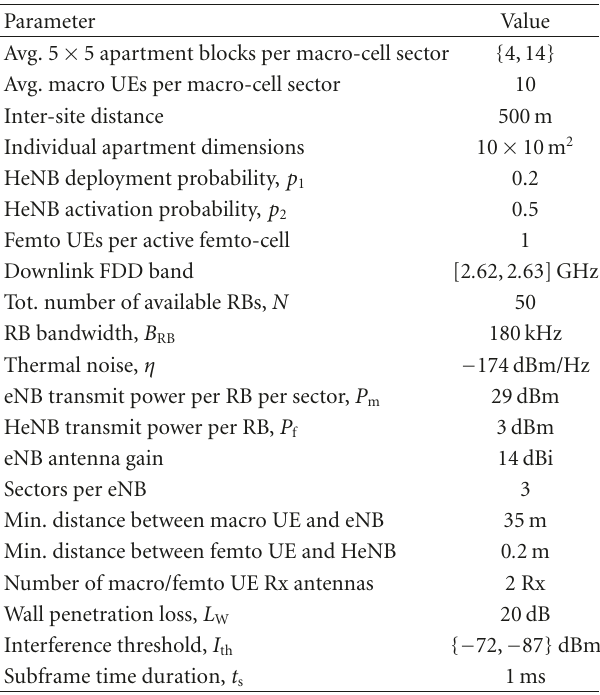
Table 3: Simulation parameters.